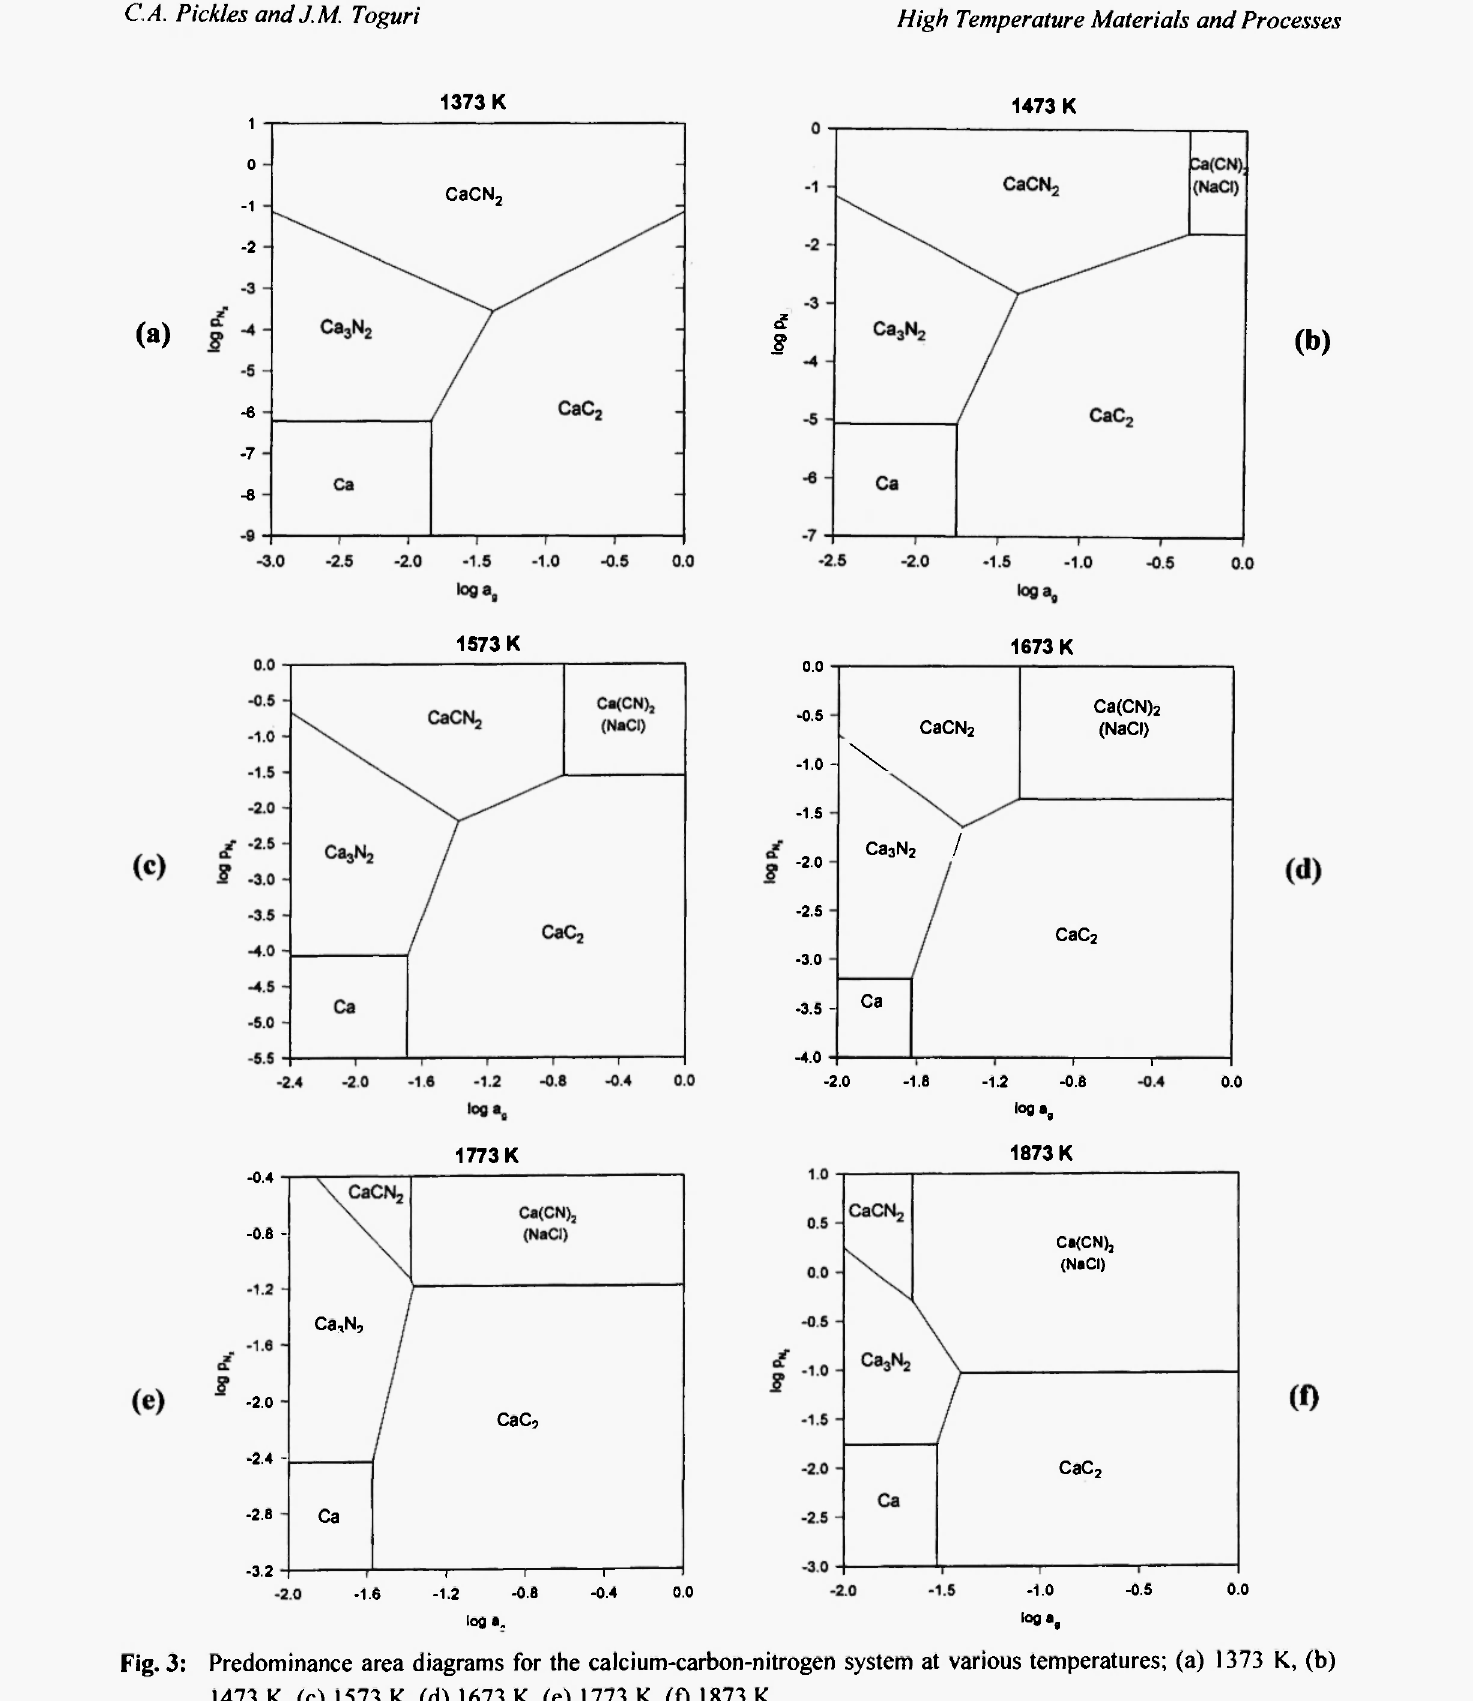
Fig. 3: Predominance area diagrams for the calcium-carbon-nitrogen system at various temperatures; (a) 1373 K,